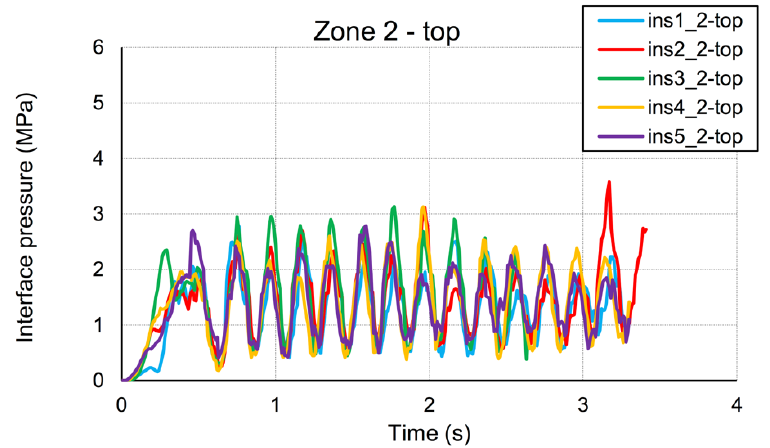
Figure 3. The pressures entity during the different random insertions of the PTN X2 in the simulated canal (specifically Zone 2, Top). The pressures during all the insertions are comparable.